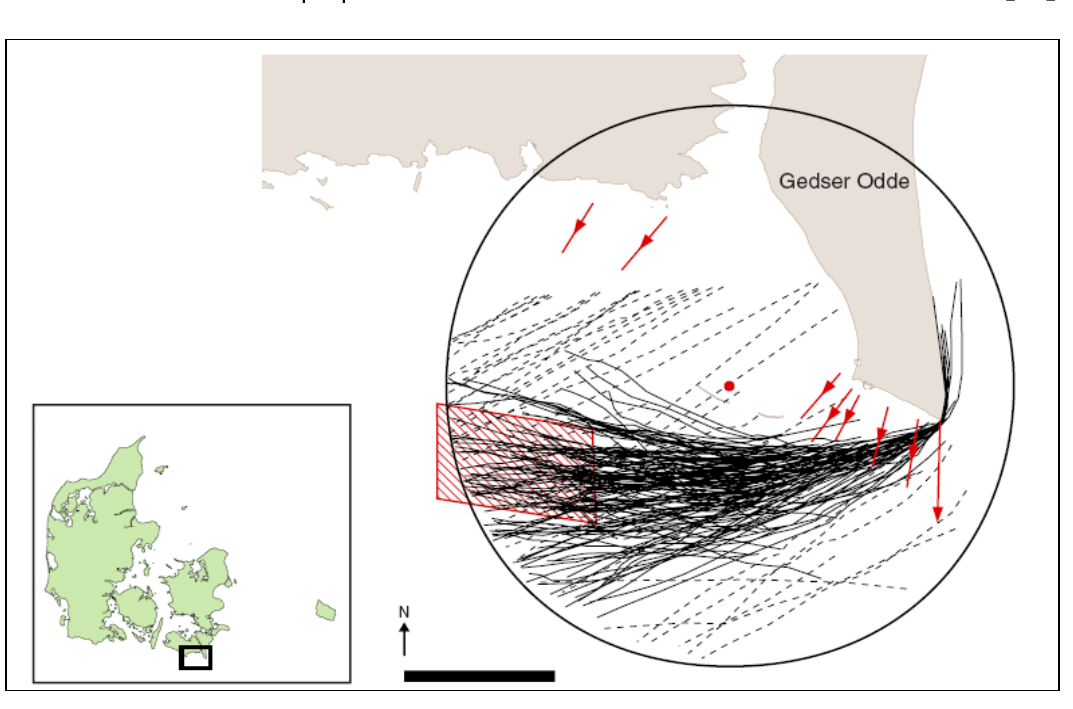
Figure 4. The Gedser Odde peninsula, Denmark, as the proposed site of the Nysted offshore wind farm showing the preconstruction migration pattern of geese (broken lines) and common eider (solid lines) recorded by radar; red lines denote land migration patterns, the red hatched area is the proposed wind farm site and the red dot is the radar tower